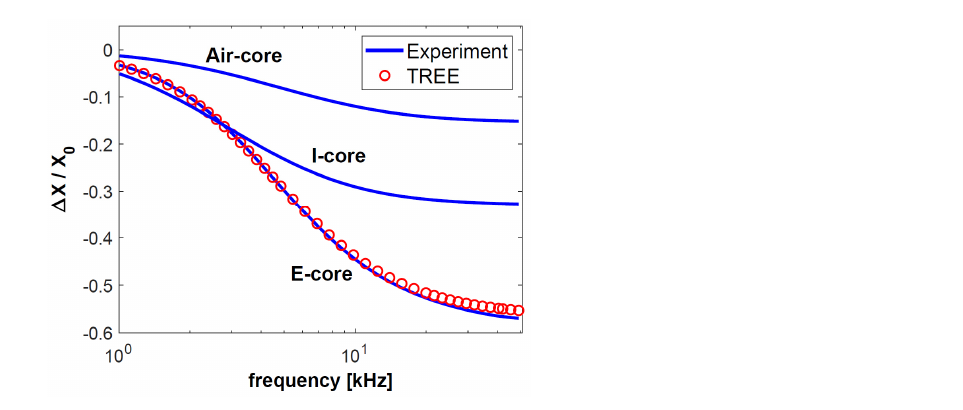
Figure 6. The changes in the resistance Δ R normalised with respect to the reactance X 0 for sample made of brass and copper.